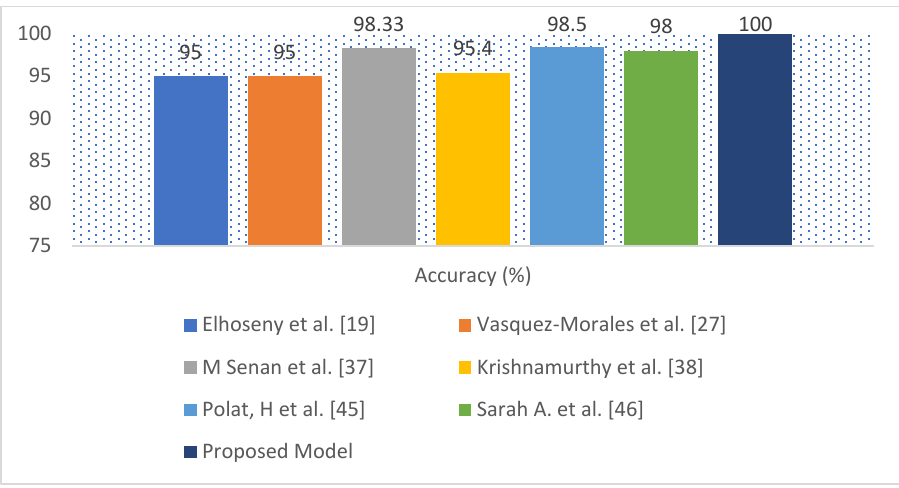
Figure 10. Accuracy graphical representation for the UCI CKD data set.